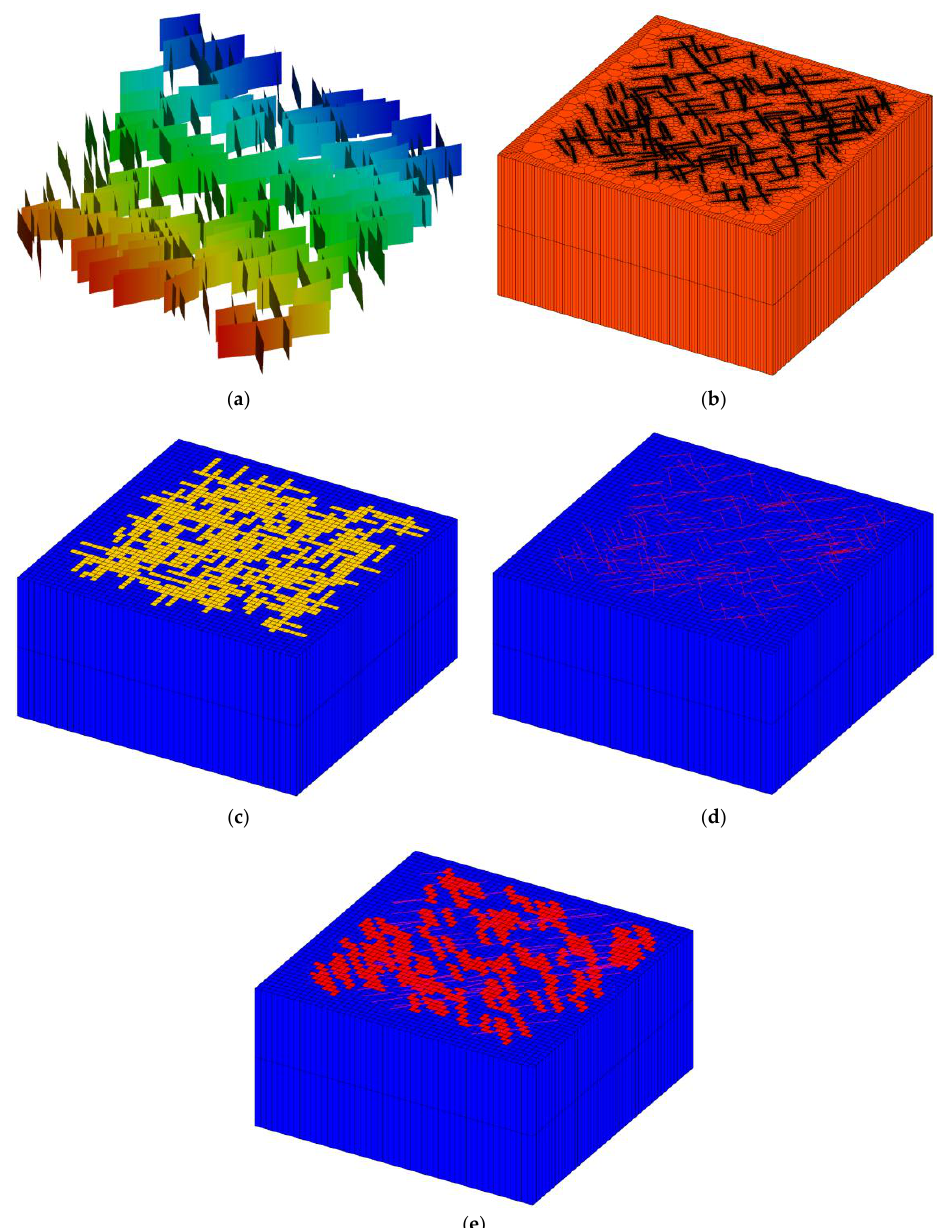
Figure 4. Fracture model. ( a ) Fracture model; ( b ) DFM; ( c ) Dual-porosity model; ( d ) EDFM; and, ( e ) hybrid EDFM-DPDP method.